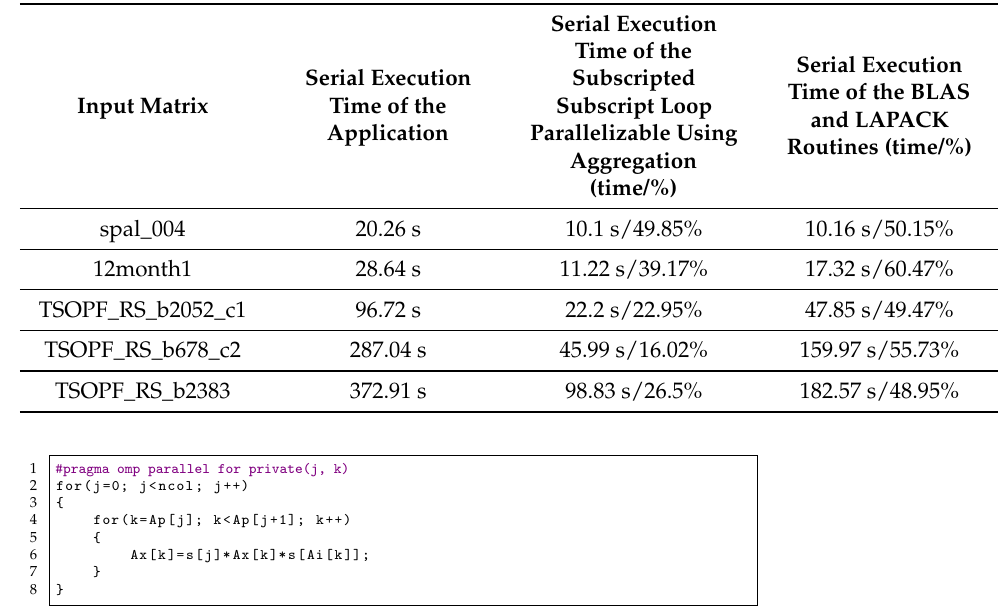
Table 2. Serial execution time of the supernodal sparse Cholesky factorization application, showing overall time and time of the parallelizable parts.